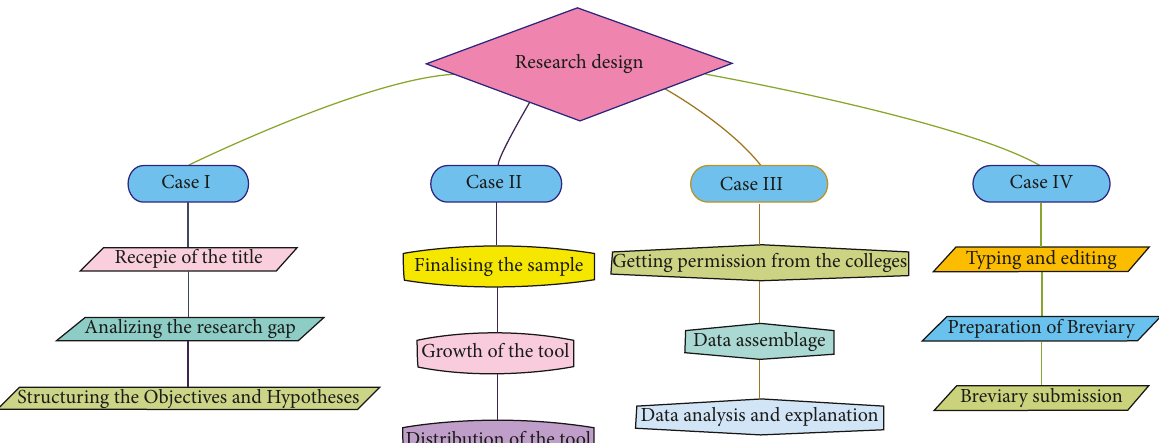
Figure 1: An overview of the study’s